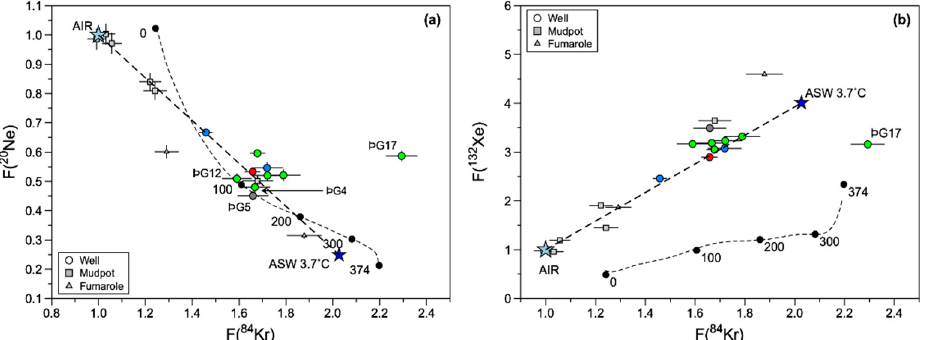
Figure 5. ( a ) F( 20 Ne) vs. F( 84 Kr), and ( b ) F( 84 Kr) vs. F( 132 Xe) measured in the surface (mudpots and fumaroles) and well fluid samples of Theistareykir. The straight lines represent the mixing between an air and an ASW component. The curves represent the solubility-controlled fractionation of F(i) values in the vapor phase after fluid boiling in the reservoir (after data from [16]).